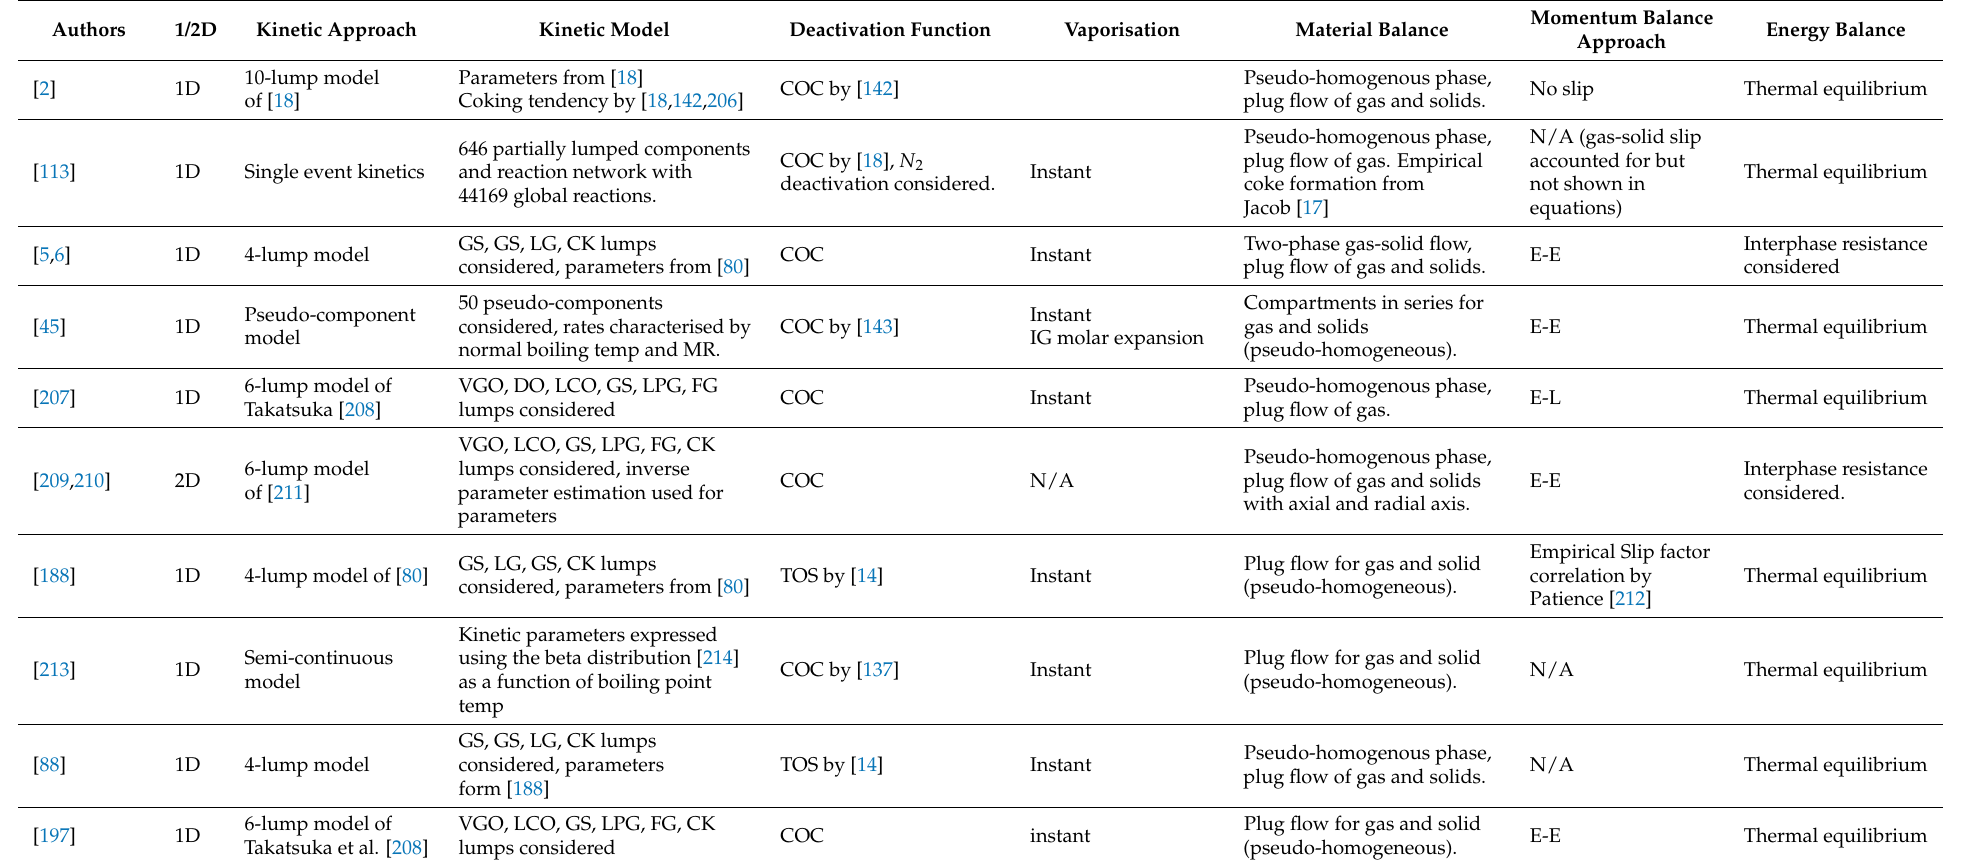
Table 8. Summary of FCC riser models in the